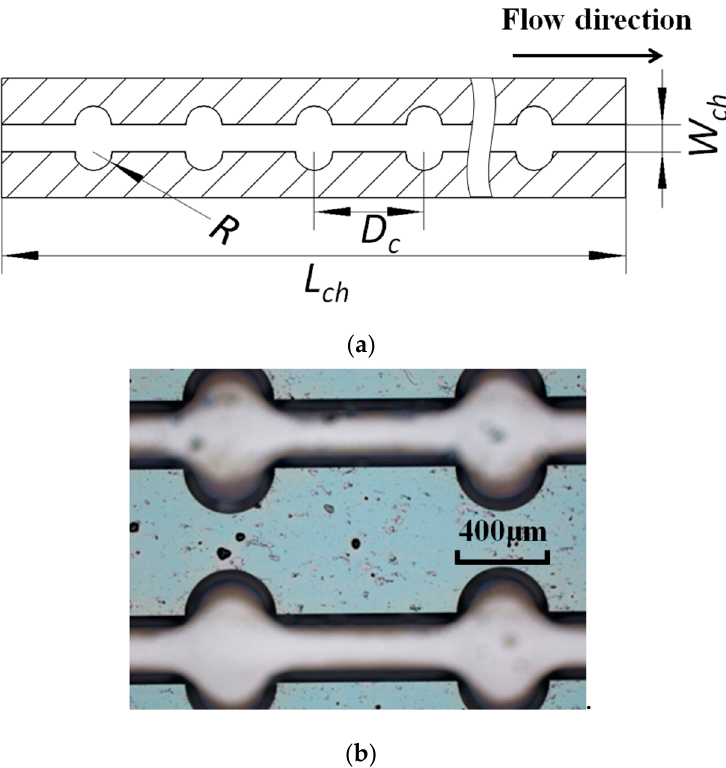
Figure 1. Structure of microchannels with reentrant cavities. ( a ) Structural parameters of a microchannel; and ( b ) Test section #4 observed with microscope.